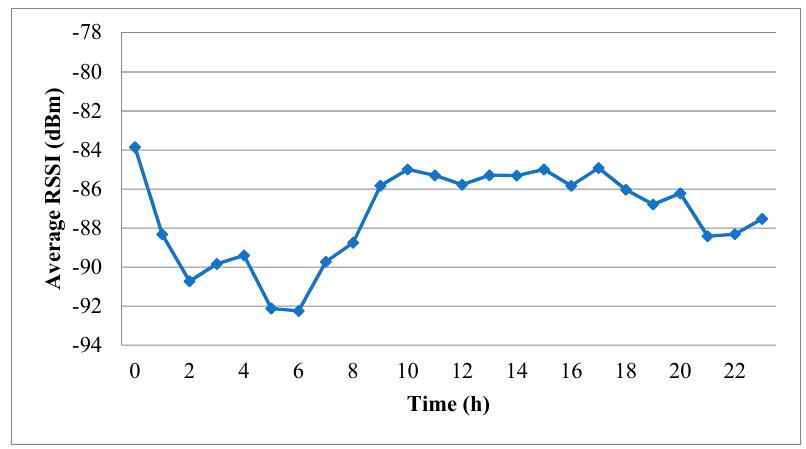
Figure 4. Average Received Signal Strength Indicator (RSSI) value in each hour of the experimental measurement period.